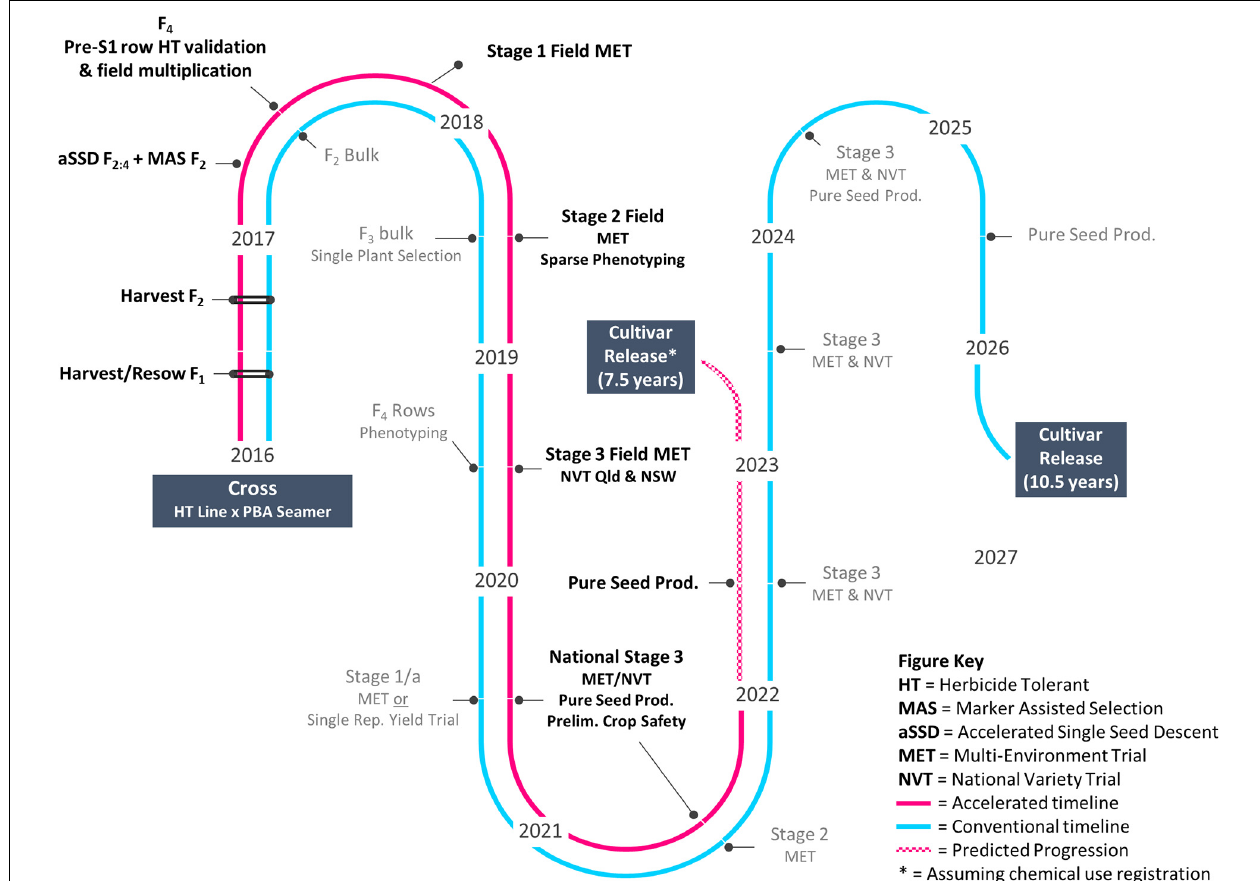
FIGURE 1 | Accelerated vs. conventional trait introgression